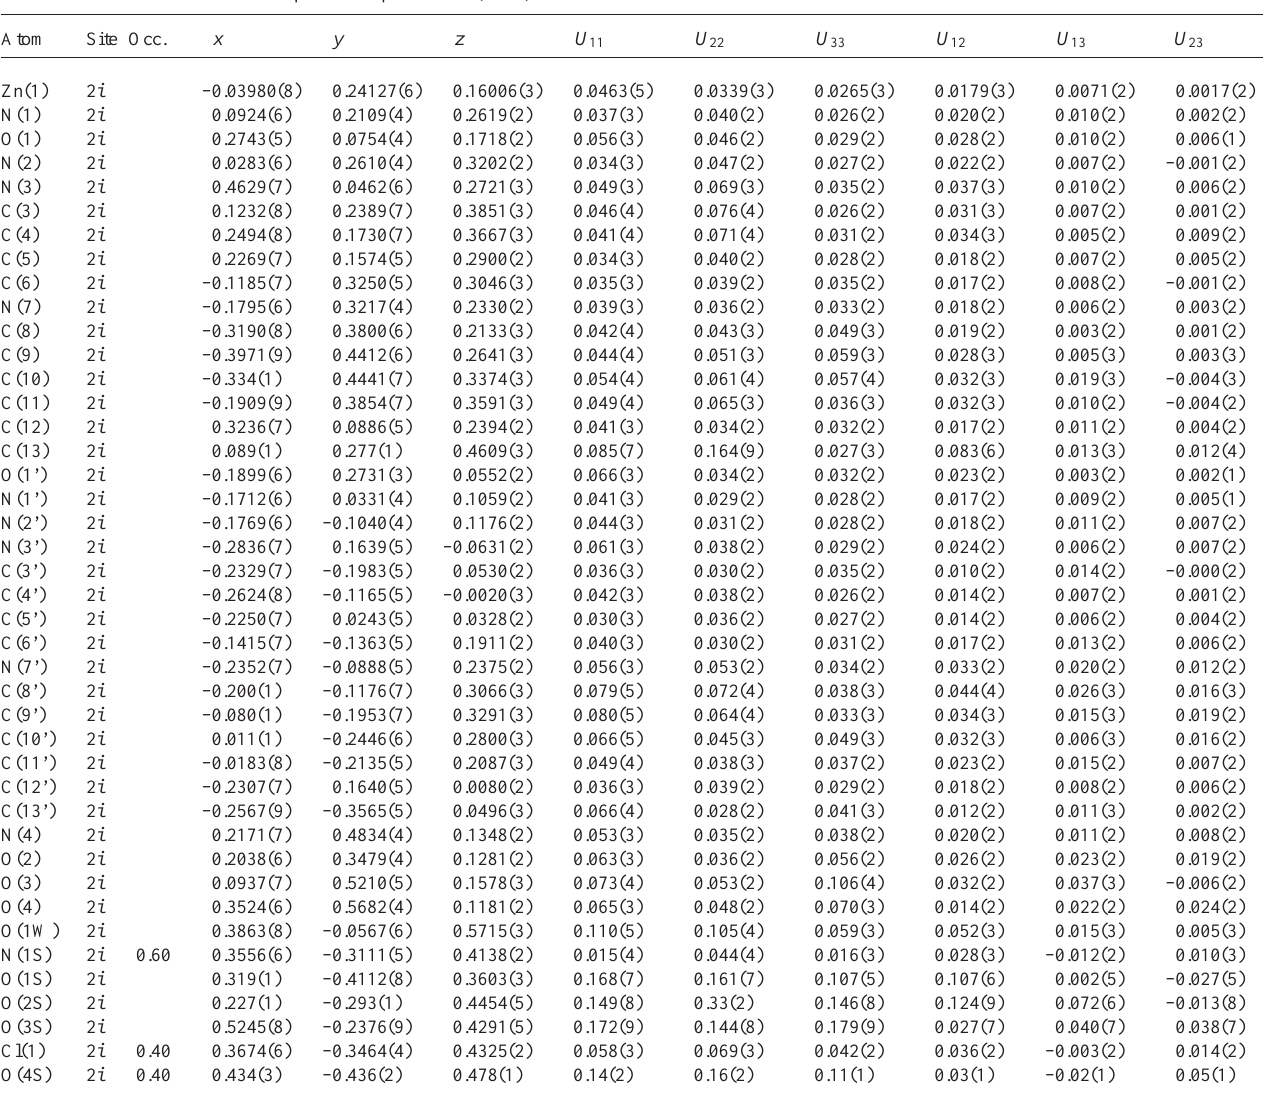
Table 3. Atomic coordinates and displacement parameters (in Å 2 ) .